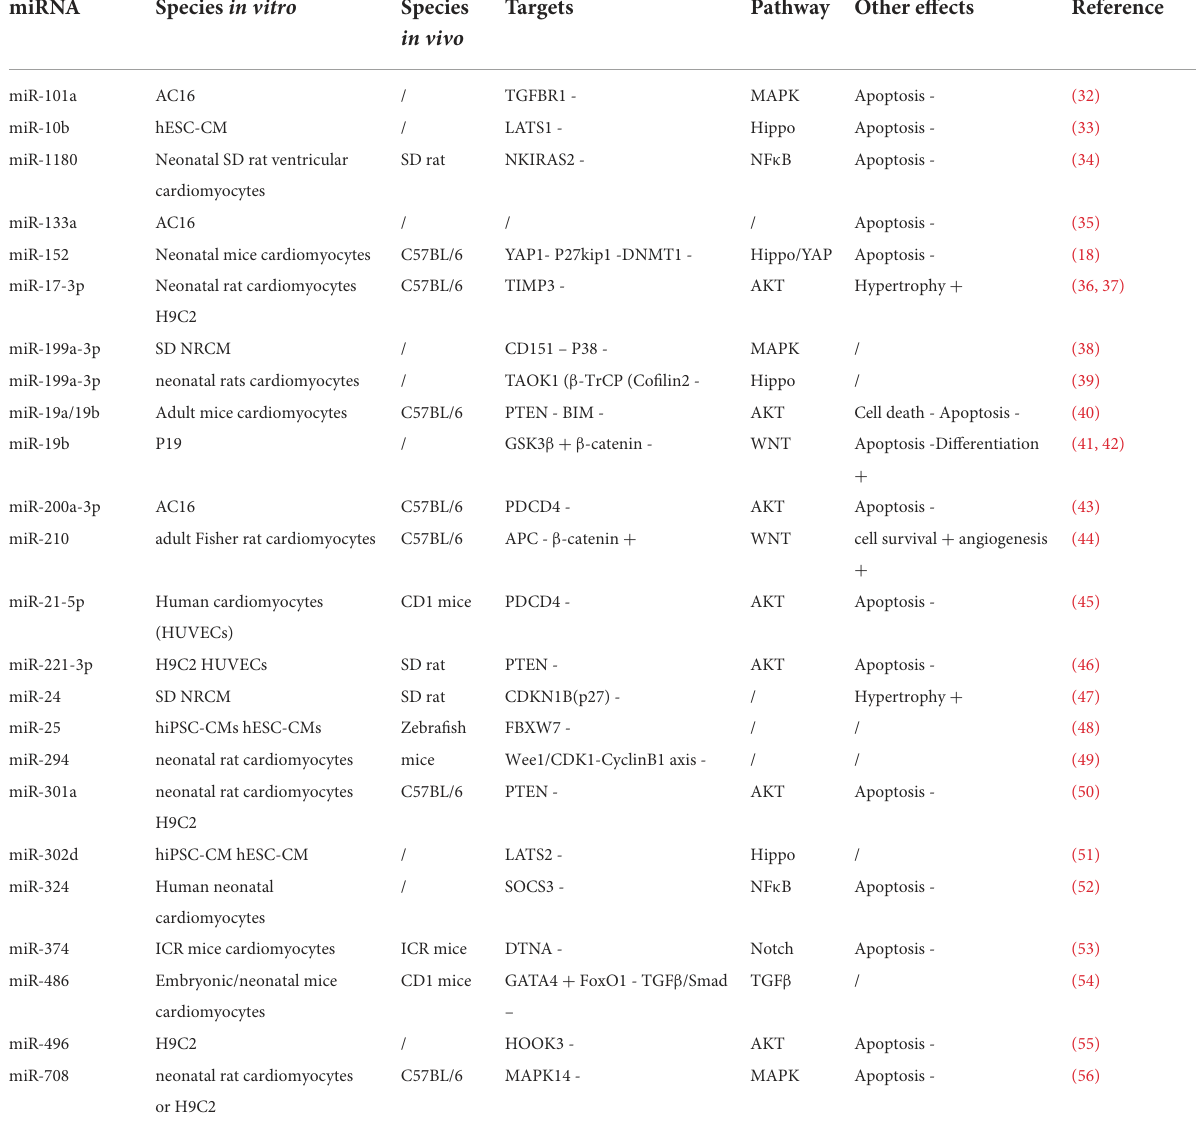
TABLE 1 A summary of the in vitro and in vivo effects of miRNAs on enhanced cardiomyocyte proliferation and the potential mechanism. miRNA Species in vitro Species Targets Pathway Other